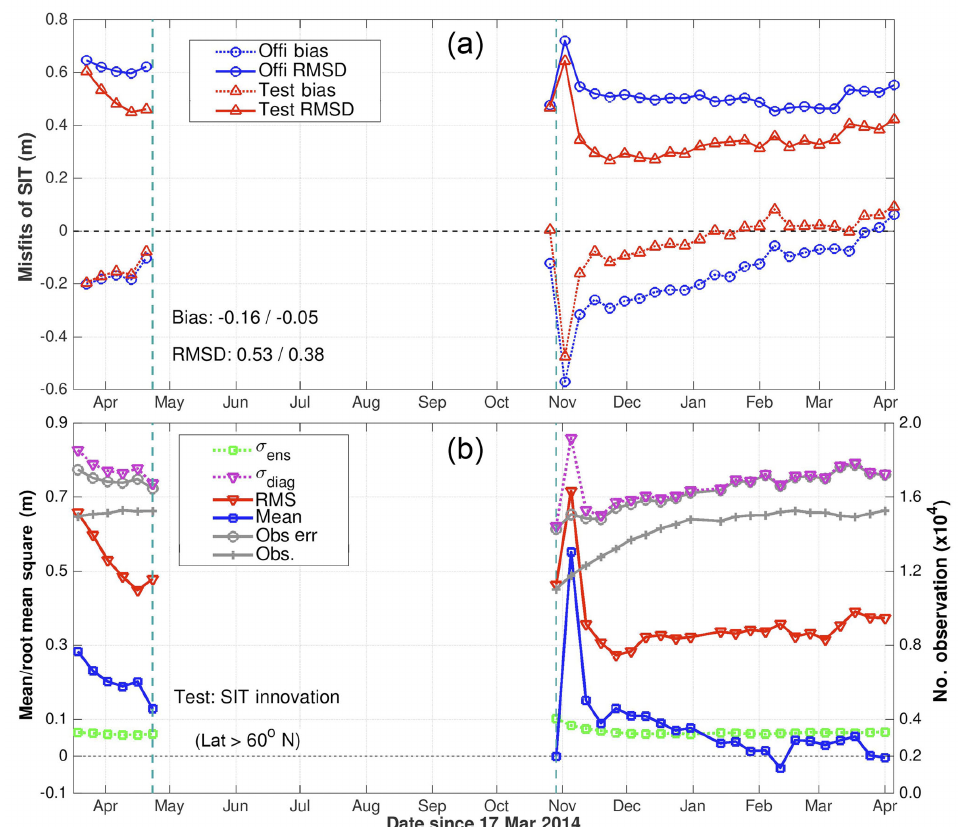
Figure 4. (a) Bias (dotted line) and RMSD (solid line) of SIT in the two runs – Official (blue) and Test (red) – based on weekly averaged reanalysis and CS2SMOS observations. The time-averaged bias and RMSD are indicated (Official/Test). (b) SIT innovation statistics in the Test run in the Arctic region ( > 60 ◦ N) from 19 March 2014 to end of March 2015. The blue-squared (red reverted-triangle) line represents the mean (RMSD) of the innovation. The green squared line represents the ensemble spread and the purple reverted-triangle line is the diagnosed total uncertainty (see Eq. 8). The gray-crossed (gray-circled) line is the number (RMSD observation error) of assimilated